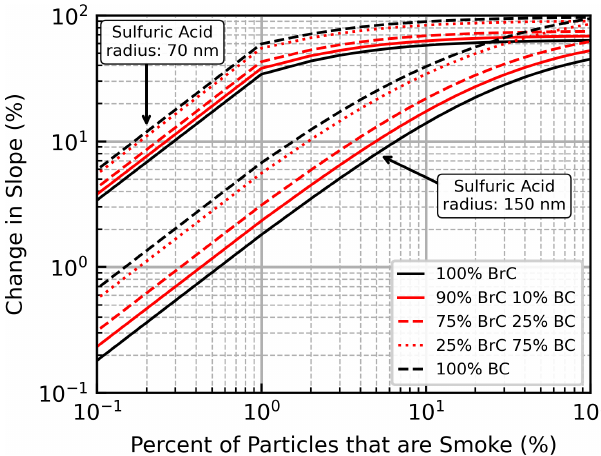
Figure 3. Change in spectral slope, relative to pure sulfuric acid aerosol, as a function of smoke fraction for five smoke composi- tions. Here, when 10% of the particles are smoke, the remaining 90% are sulfuric acid. The smoke particles had a mode radius of 200nm and distribution width of 1.5. The sulfuric acid distributions had a width of 1.5 and mode radii of 70 and